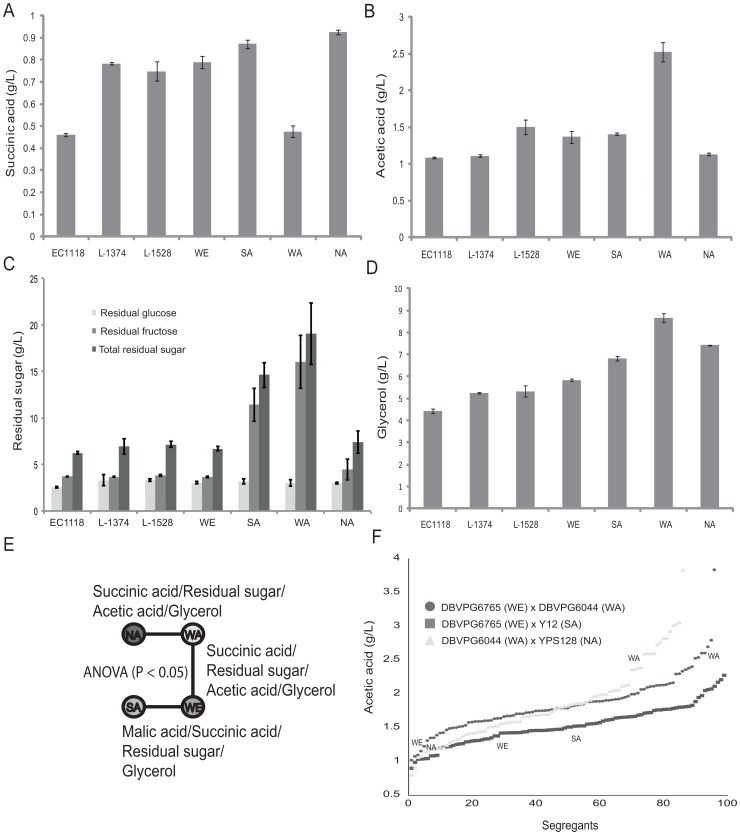
Quantitative variation in oenological phenotypes.Seven strains were phenotyped for production of key metabolites for wine making after 20 days fermentation. Three strains (EC1118, L-1374, L-1578) are used in real wine making setting. The other strains are representative of diverged genomic clusters and used for QTL mapping. (A) Succinic acid production. (B) Acetic acid production. (C) Residual sugar. (D) Glycerol production. (E) Statistical differences in the oenological phenotypes between the parental strains. (F) Example of continuous distribution in acetic acid production of segregants from three crosses.